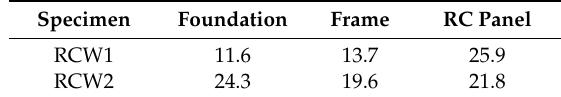
Figure 4. Dimensions and reinforcements of the column and beam. (unit: cm).